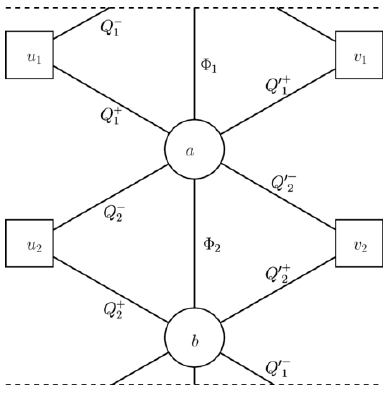
Figure 4 . The Z 2 orbifold of N = 2 su (2) SQCD with four (cid:13)avors. The quiver is drawn on a cylinder. There is a superpotential term for each triangle in the